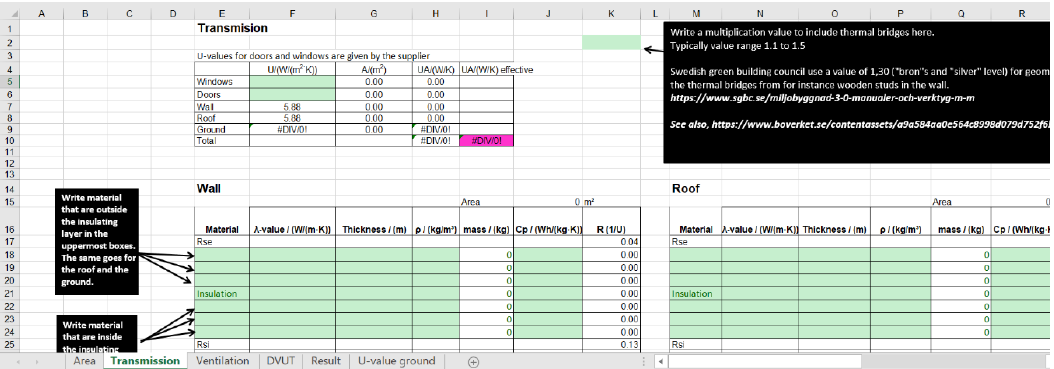
Figure 3. Screenshot of the Excel sheet based on BBR, as provided to students for the control method.